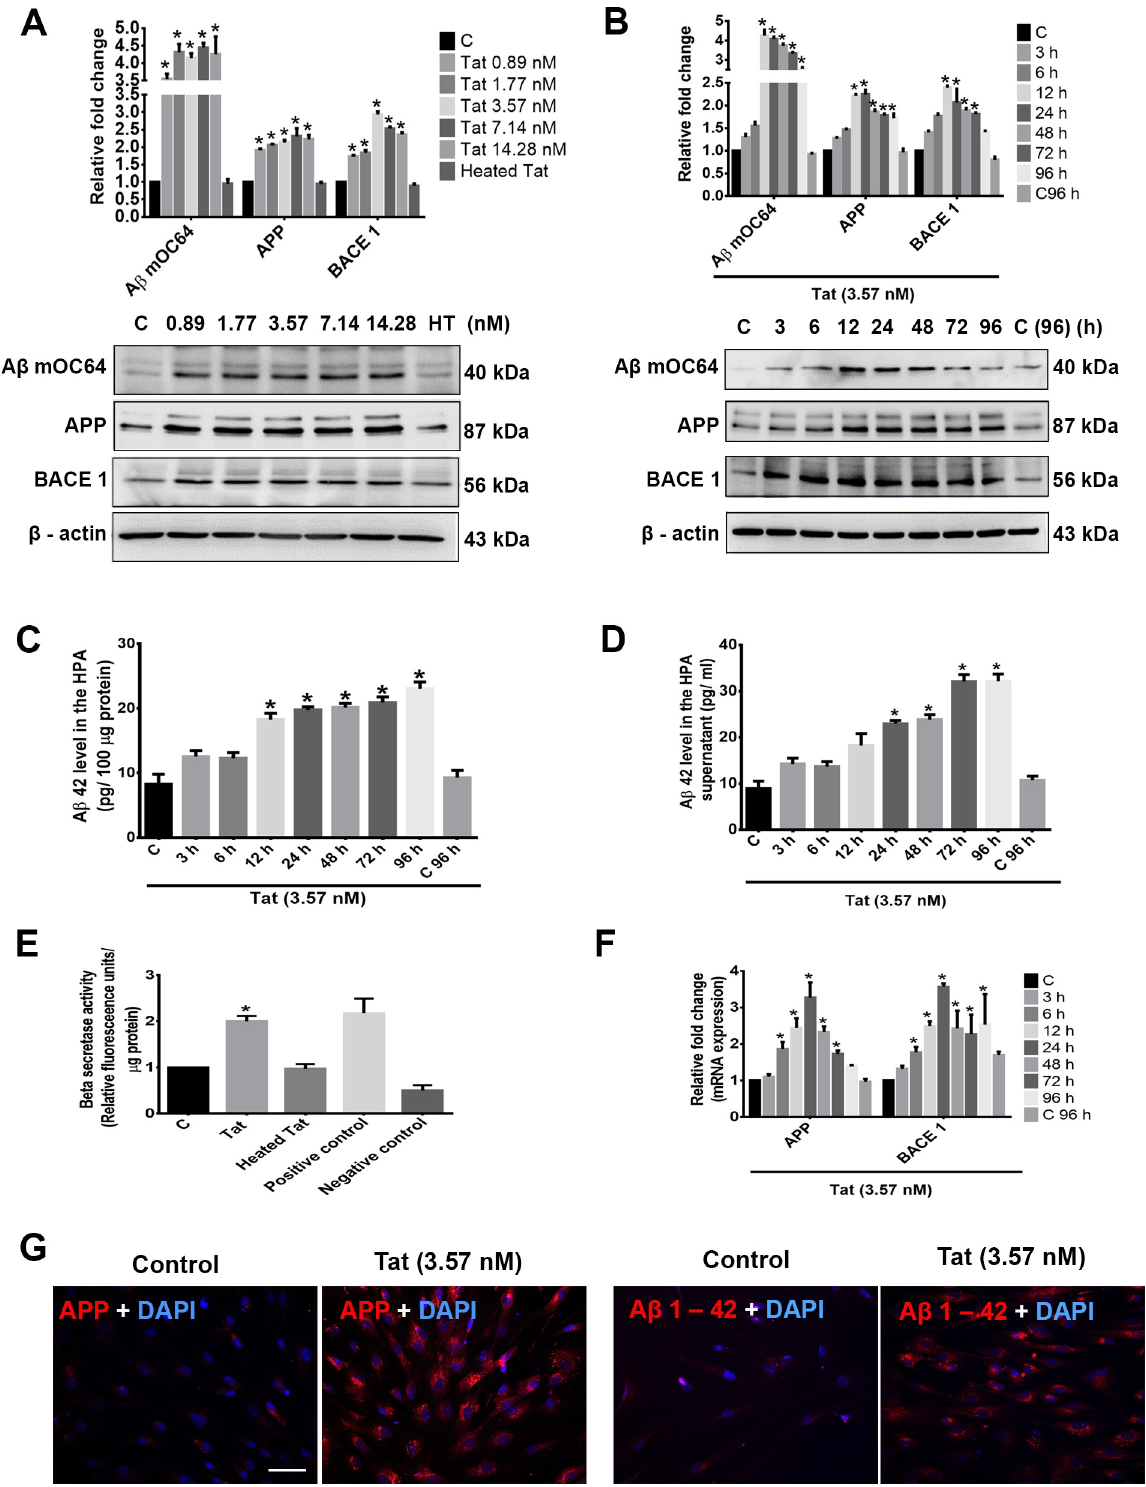
Fig 5. HIV-1 Tat–mediated amyloidosis in HPAs. Western blot analysis showing dose- (A) and time-dependent (B) up-regulation of A β mOC64, APP, and BACE1 in HPAs exposed to HIV-1 Tat at the indicated doses and time points. β -actin was used as an internal control. ELISA assay showing time-dependent up-regulation of A β 42 protein in HPA lysates (C) as well as in the supernatant fluids (D) following exposure of cells to HIV-1 Tat (3.57 nM). (E) HIV-1 Tat (3.57 nM)–exposed HPAs showed increased β -secretase activity by spectrofluorometric analysis. (F)